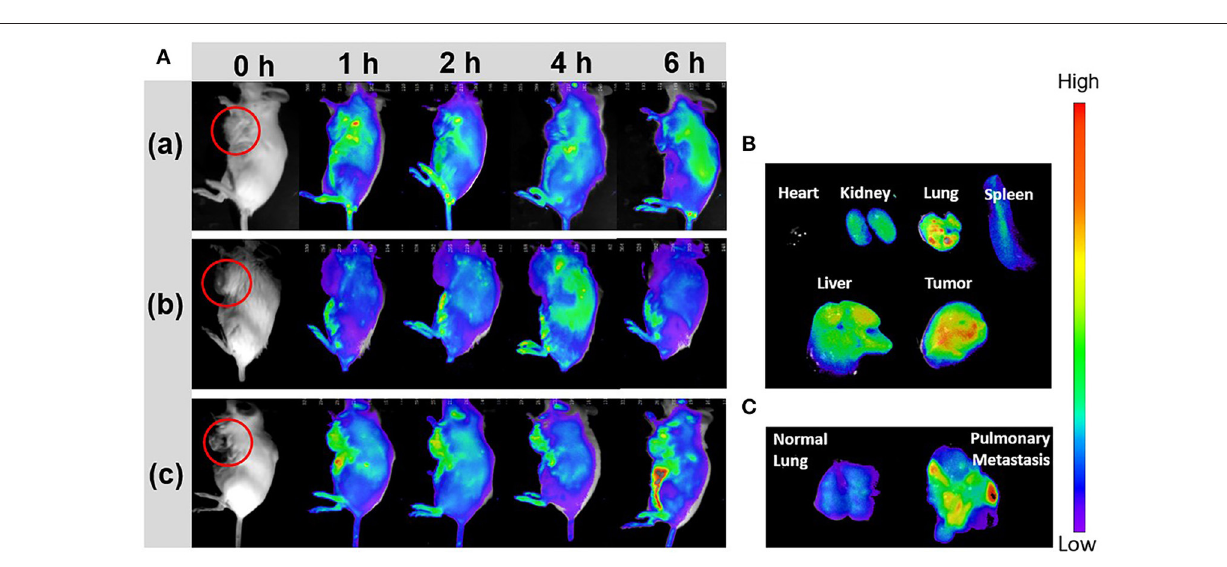
and bladder accumulations were also obvious ( Figure 5A